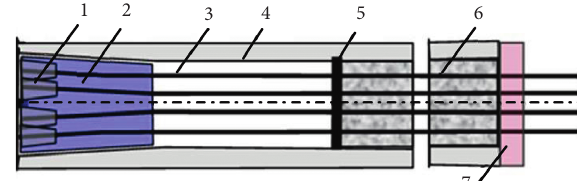
Figure 4: Schematic diagram of the constant resistance device [16] (1, steel strand group anchor clip; 2, constant resistance body; 3, steel strand; 4, constant resistance casing; 5, antiwinding slurry barrier; 6, filling material; 7, antiskid baffle).